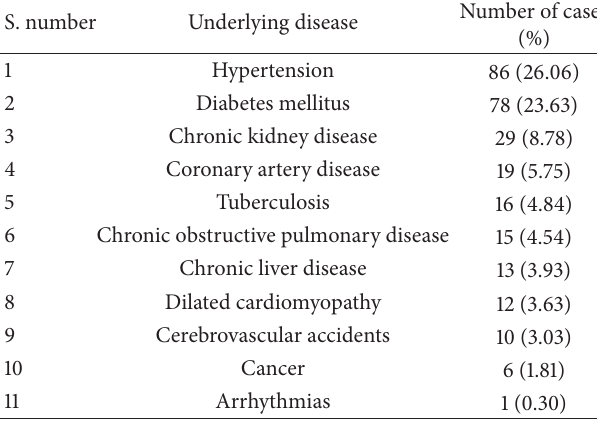
Table 1: Various comorbid conditions in the cases studied.